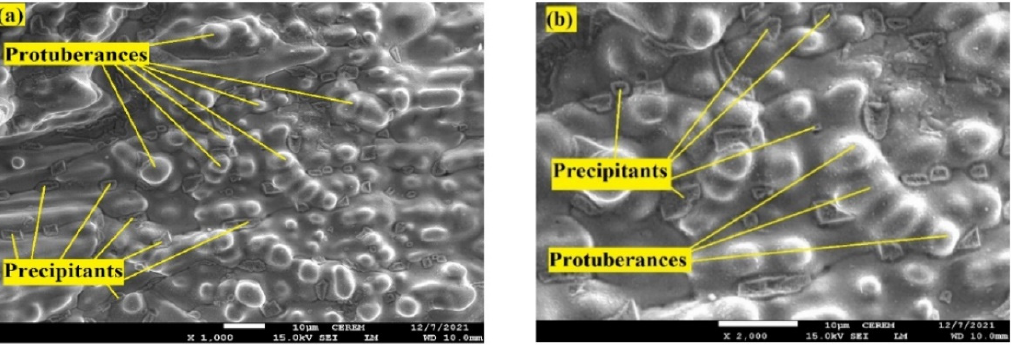
Figure 8. SEM micrographs of crack face of TIG weld specimen without coating powder ( a ) (×1000) and ( b ) (×2000).